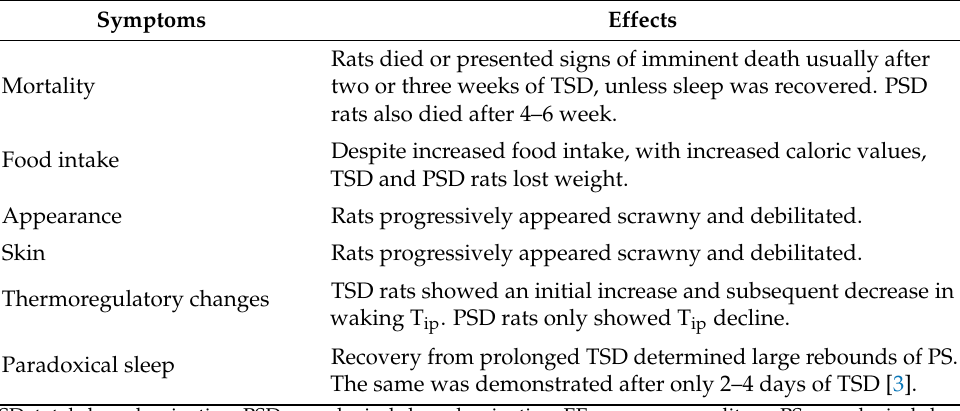
Table 1. Major sleep deprivation effects in